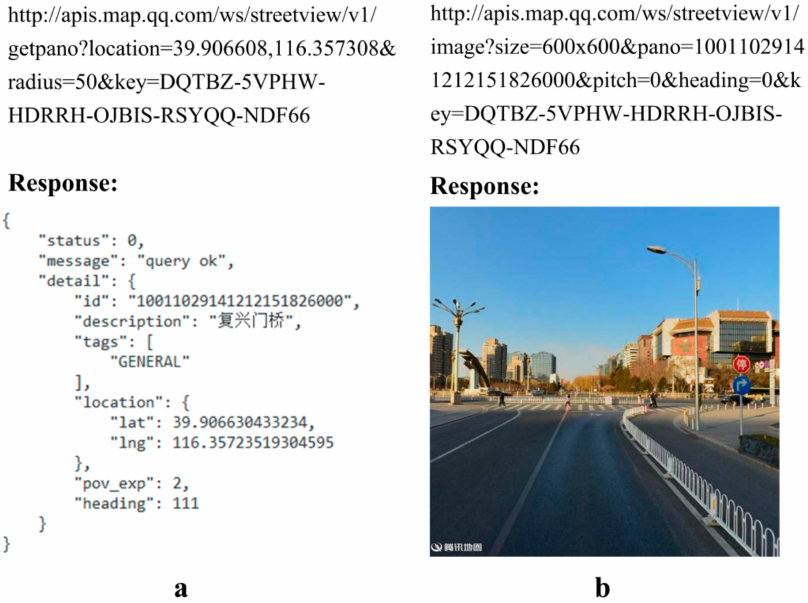
Figure 4. ( a ) uniform resource locator (URL) response of Tencent WebService and ( b ) static image application program interface (API).